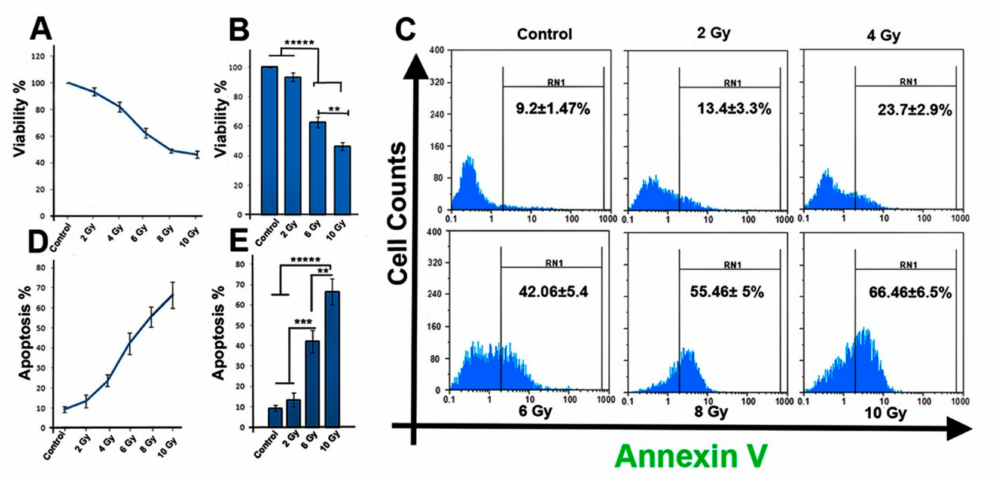
Figure 1. ( A,B ) Ionizing radiation (IR) reduced MCF-7 cells survival rate over 48 h after irradiation. ( C ) Flow cytometric analysis of apoptotic cells in all irradiated groups. ( D , E ) Percentage of apoptotic cells was increased in IR-treated cells. One-way ANOVA with Tukey test was applied. All values are means ± SD; n = 3. * * p < 0.01, *** p < 0.001, ***** p <